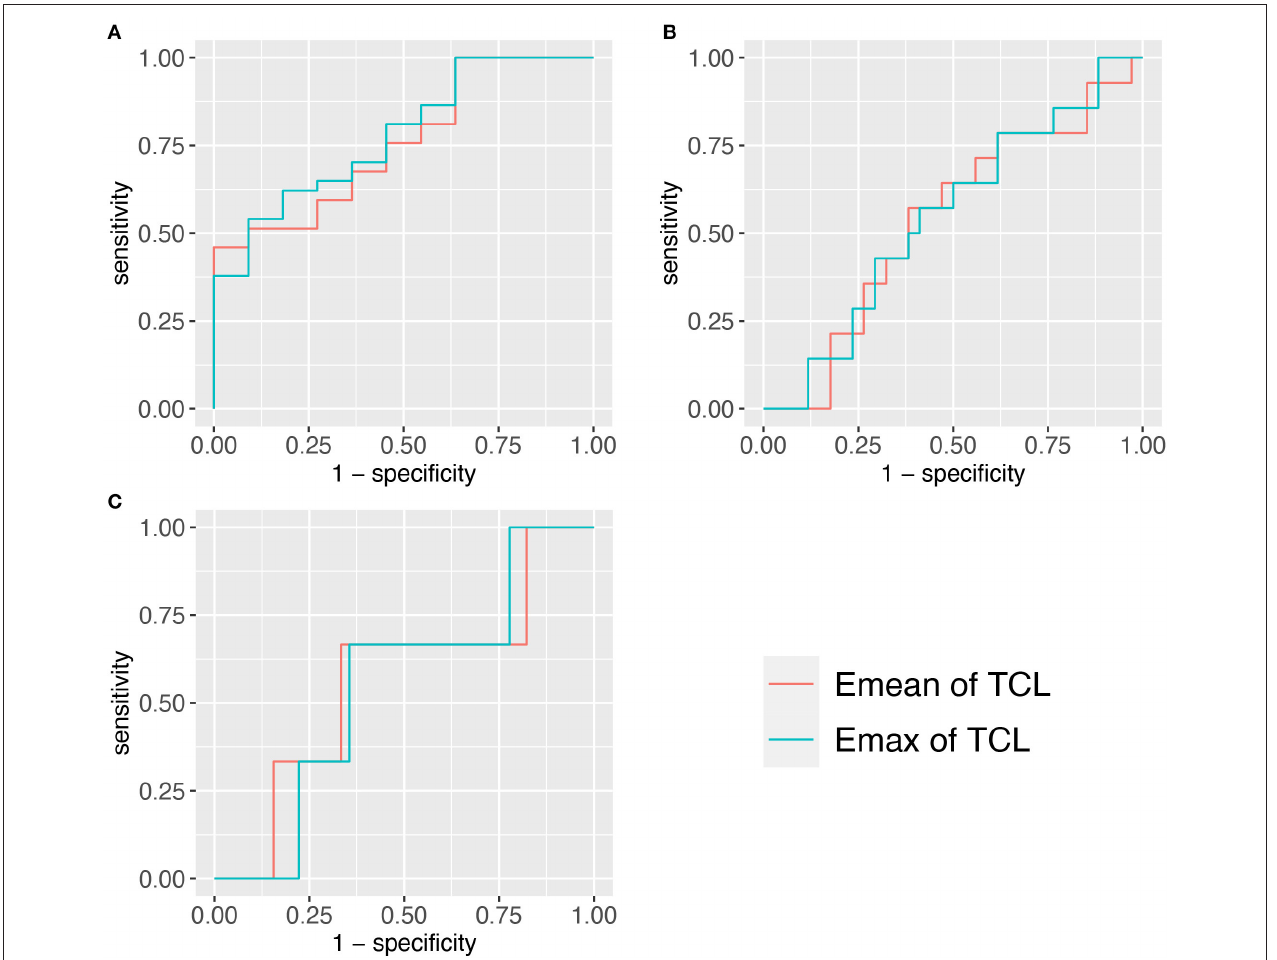
FIGURE 4 | Three ROCs of TCL stiffness at the distal carpal tunnel (DCT) to diagnose different NCS severity. (A) <Moderate group. (B) <Severe group. (C) <Extreme group. TCL, transverse carpal ligament; SWE, shear wave elastography; ROC, receiver operating characteristic curve.